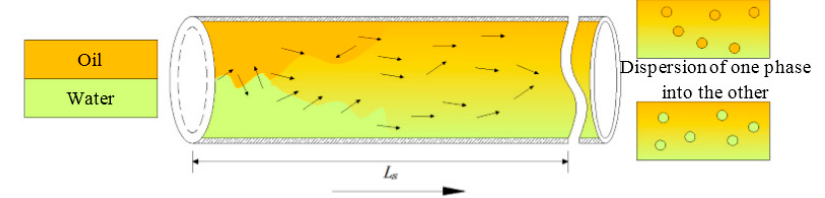
Figure 5. Description of the experienced shearing energy of emulsions flowing in a shearing field.